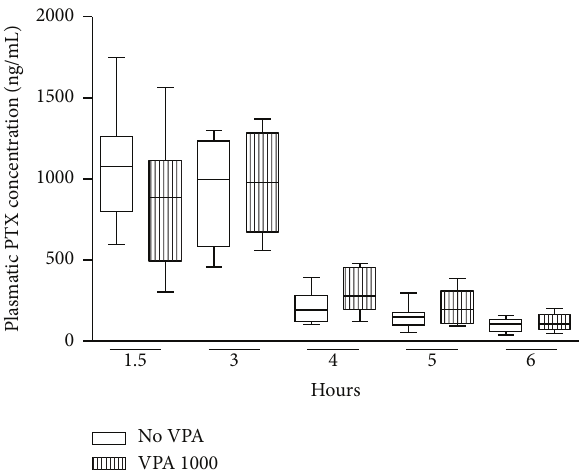
Figure 3: Median plasmatic paclitaxel concentrations for patients treated with TAX alone (VPA 0) or with VPA + TAX (VPA 1000). Boxes = 25th and 75th percentiles; bars =min and max